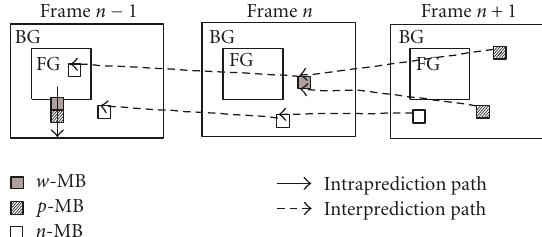
Figure 3: Illustration of the wrong reference